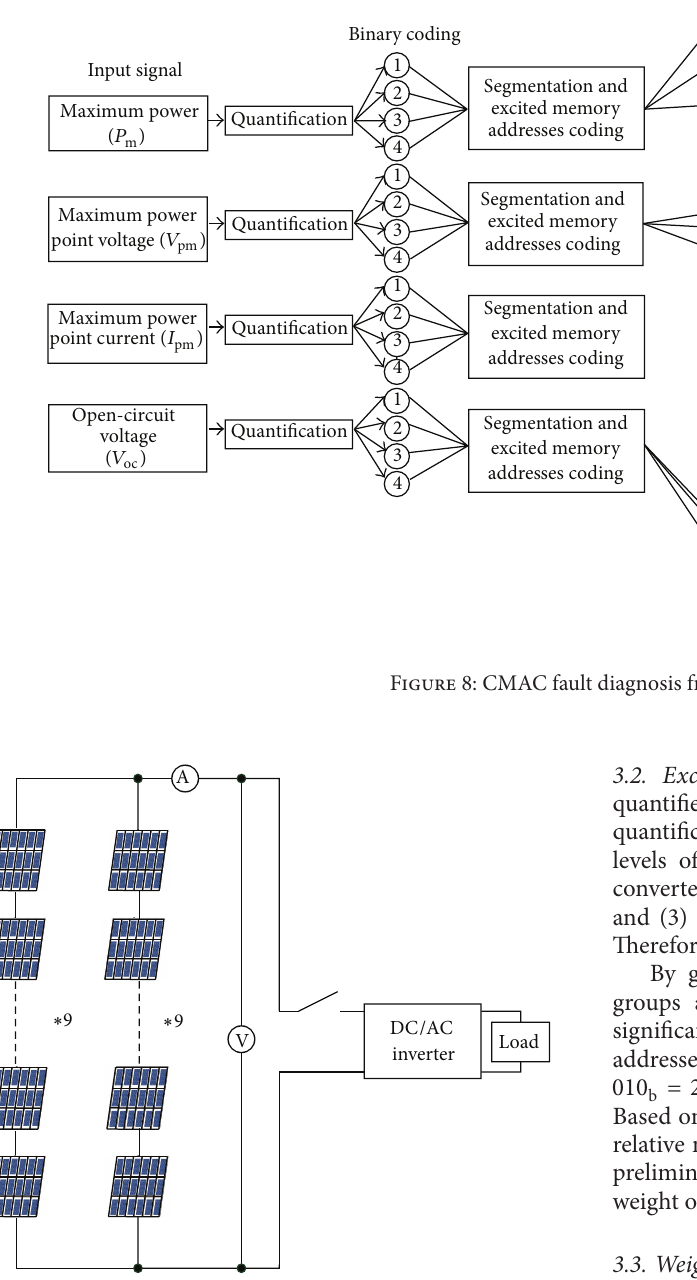
Figure 9: The photovoltaic power generation system featuring 9 series and 2 parallel